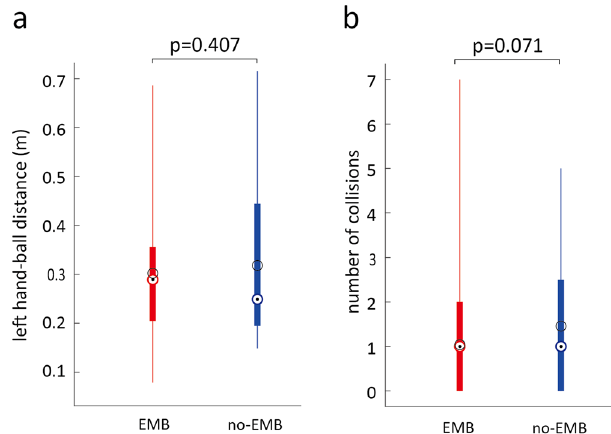
Fig. 4 Secondary (collision avoidance) task performance. No differences were observed between either ( a ) the distance of the ball from the left hand ( Z (23) = 0.8286, P = 0.407, Wilcoxon signed-rank test), or ( b ) the number of collisions ( Z (23) = 1.806, P = 0.071, Wilcoxon signed-rank test) between the EMB (red) and no-EMB (blue) conditions. This was veri fi ed with a Kolmogorov Smirnoff test for both the ball distance ( P = 0.6216) and the number of collisions ( P = 0.6216). The black circles show the mean and the colored circle with the dot shows the median scores across participants. The box edges show the 25th and 75th percentile of the data and the whiskers show the data